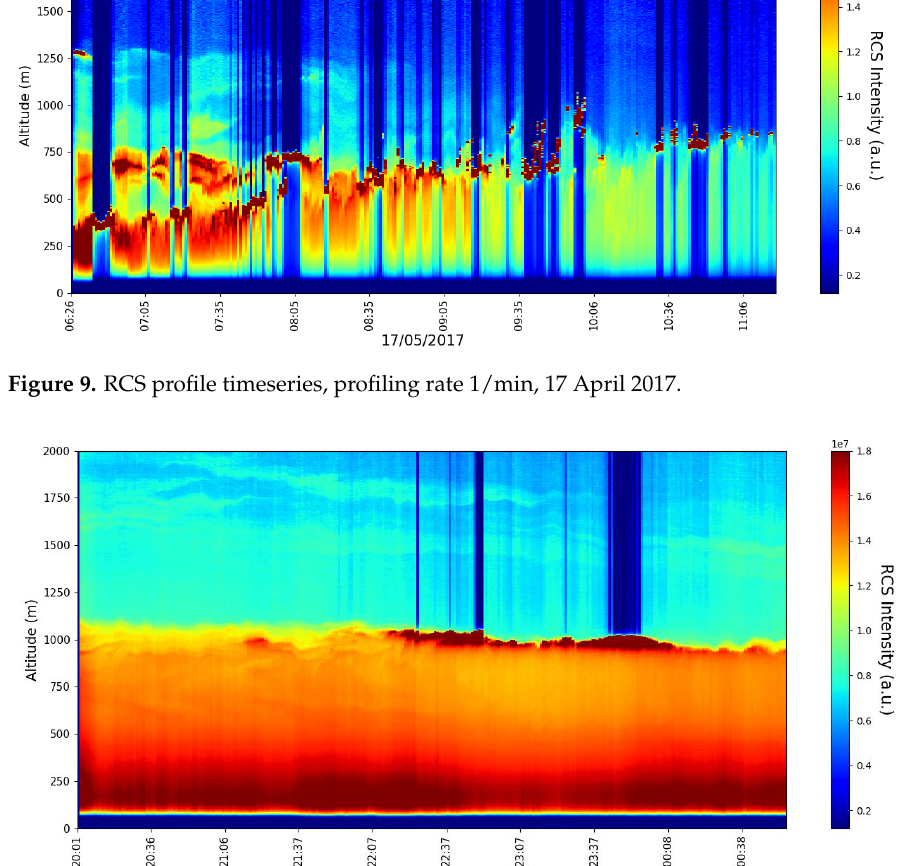
Figure 12. 𝐶 𝑁2 profile timeseries, profiling rate 1/min, 28 April 2017. Observing the rest of the timeseries, 〈𝜀〉 values seem to be lowest in or near the re- gion of the PBL (Figures 13 and 14); multiple studies seem to support the fact that tur- bulent dissipation is lowest at, or just above, the PBL, with both experimental and theo- retical data [6,22].